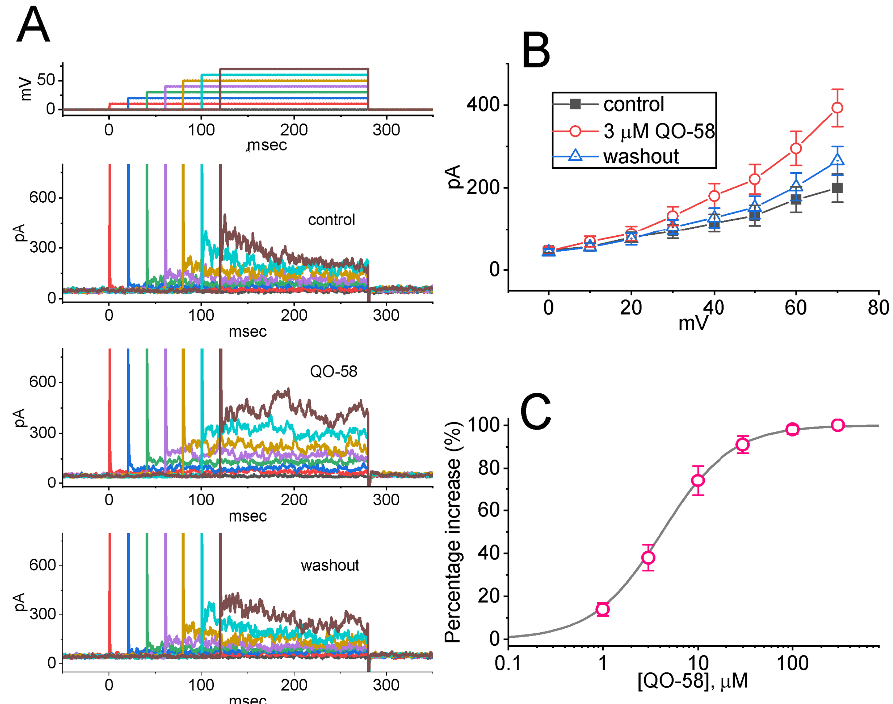
Figure 5. Stimulatory effect of QO-58 on the amplitude of whole-cell (i.e., macroscopic) Ca 2+ -activated K + current ( I K(Ca) ) measured from GH 3 cells. In this series of voltage-clamp current recordings on these cells, we used normal Tyrode’s solution containing 1.8 mM CaCl 2 as a bathing medium, and the recording pipette used was backfilled with K + -enriched solution. As whole-cell configuration was established, we evoked I K(Ca) from a holding potential of 0 mV to test potentials in the range of 0 and +70 mV (10-mV in increments) at a rate of 0.1 Hz. ( A ) Superimposed current traces activated in response to a series of voltage steps (indicated in the uppermost part). Current traces in the upper part are controls (i.e., absence of QO-58), those in the middle part were recorded during cell exposure to 3 µ M QO-58, while those in lower part were taken after washout of the QO-58. The duration of rectangular voltage commands applied was set in the range of 280 and 160 ms (20-ms decrements), indicating a progressive increase with membrane depolarization (i.e., an outwardly- rectifying property). ( B ) Average I-V relationship of I K(Ca) obtained in the control period, during the exposure to 3 µ M QO-58, and after washout of QO-58. Current amplitude was measured at the end of each depolarizing pulse. Each point represents the mean ± SEM ( n = 8). ( C ) Concentration-response relationship for QO-58-induced stimulation of I K(Ca) (mean ± SEM; n = 8 for each point). The gray continuous line drawn is reliably fitted to the Hill equation. The values for EC 50 or n H were yielded to be 4.2 μM or 1.2, respectively.